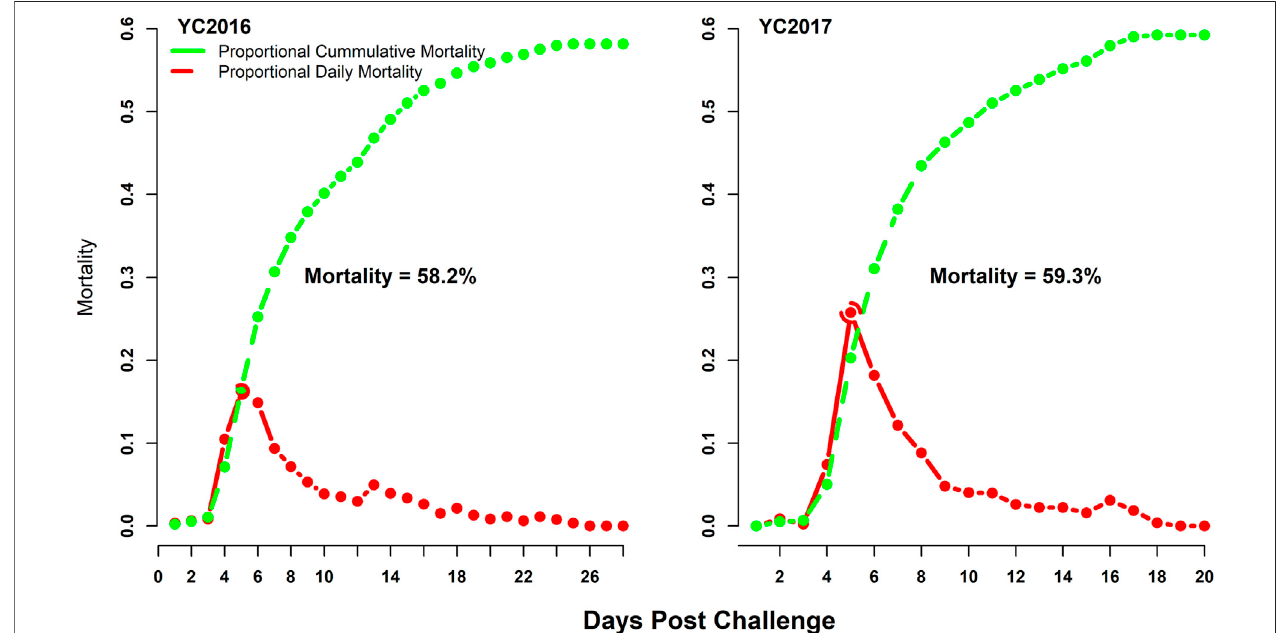
FIGURE 1 | Distribution of mortalities in YC2016 and YC2017 during the challenge test against the nervous necrosis virus.